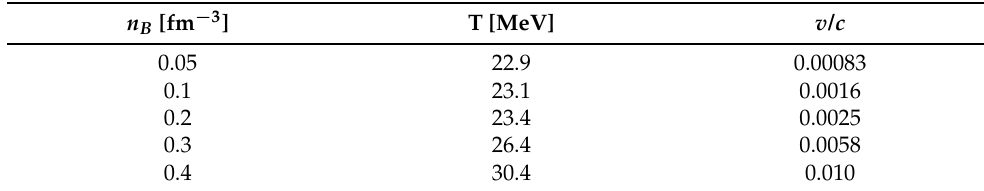
Table 1. Final temperatures of (u,d,s) ash for different initial hadronic number densities, as calculated by solving the reaction-diffusion-advection equations. Burning speed is also included for each initial hadronic number density. Reprinted from Ref.